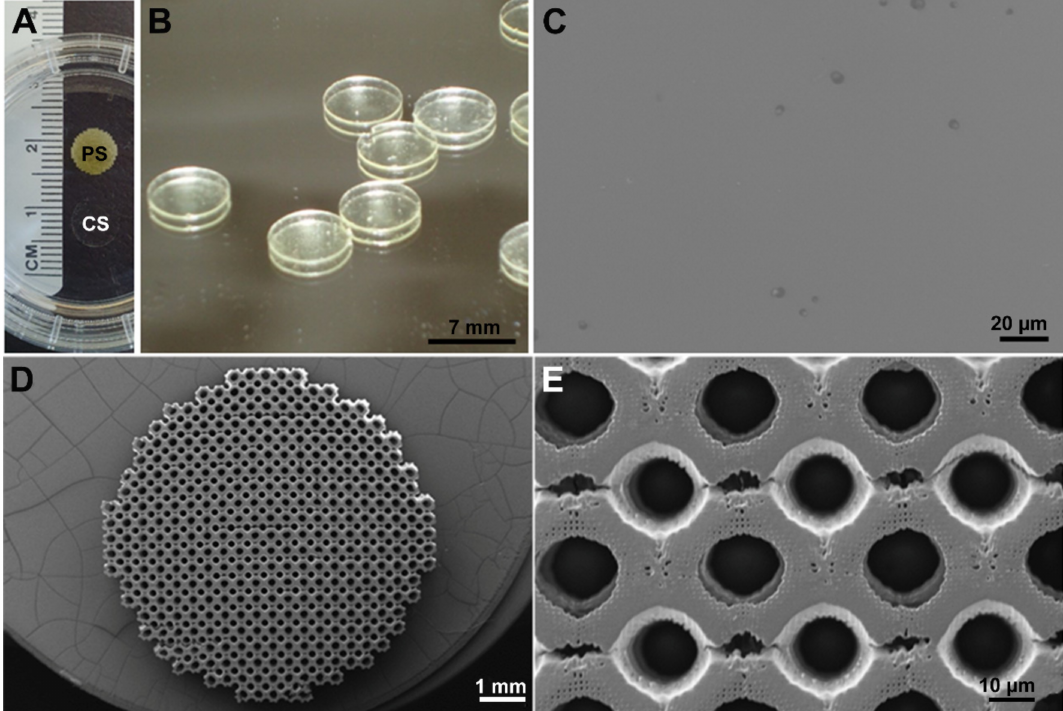
Figure 12. Images of porous (PS) and compact LCM scaffolds (CS). ( A ) Overview of PS compared to CS that is nearly transparent. ( B ) Higher magnification of CS. ( C ) Scanning electron microscopic (SEM) picture of the surface of CS. ( D ) SEM overview of PS. ( E ) Detail SEM of